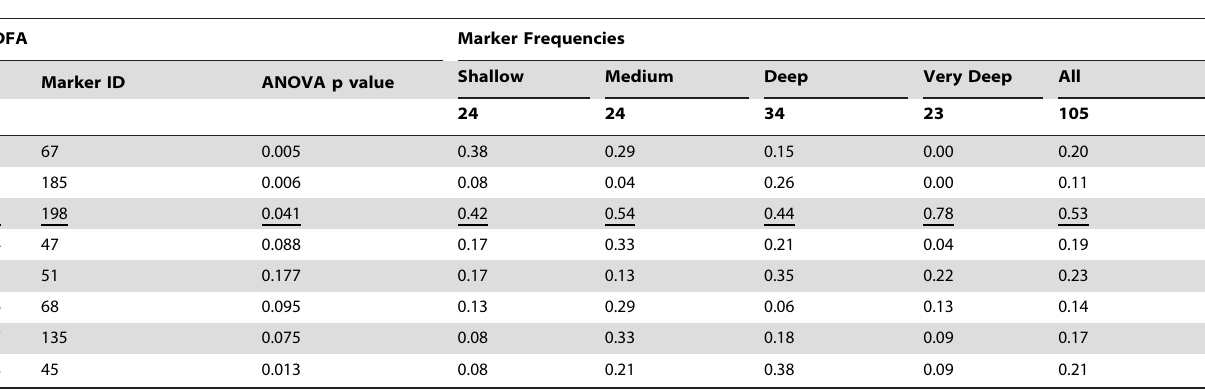
Table 8. Band frequencies for AFLP markers used in discriminant function analysis (DFA).